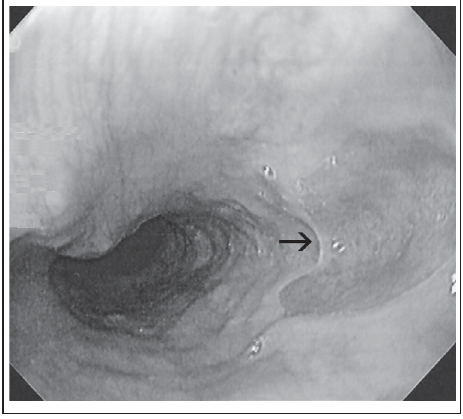
Figure 1. Endoscopic appear- ance of ectopic gastric mucosa (arrow) with a smooth, regular and velvety islet of columnar tis- sue in the upper esophagus.